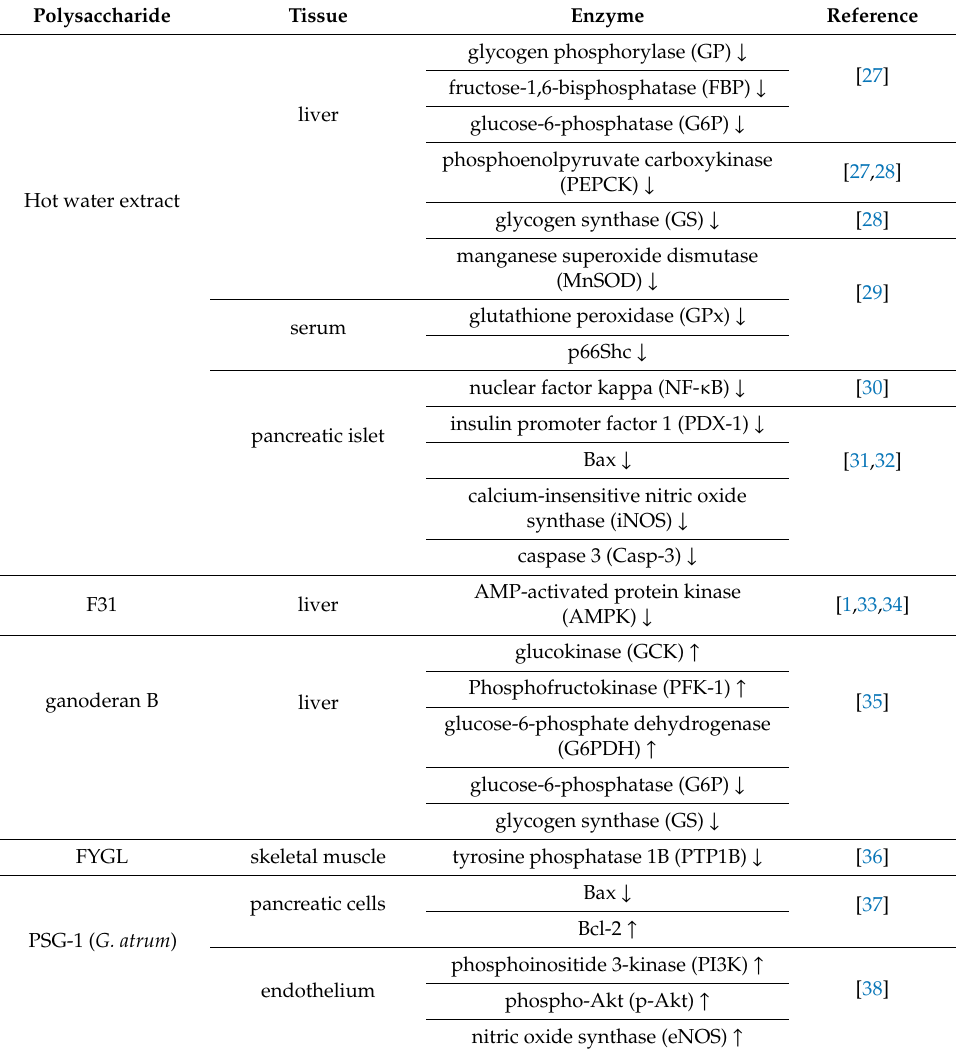
Table 2. Antidiabetic activity of Ganoderma